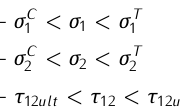
Fig.7. Finite element model of 8A and 8B impellers